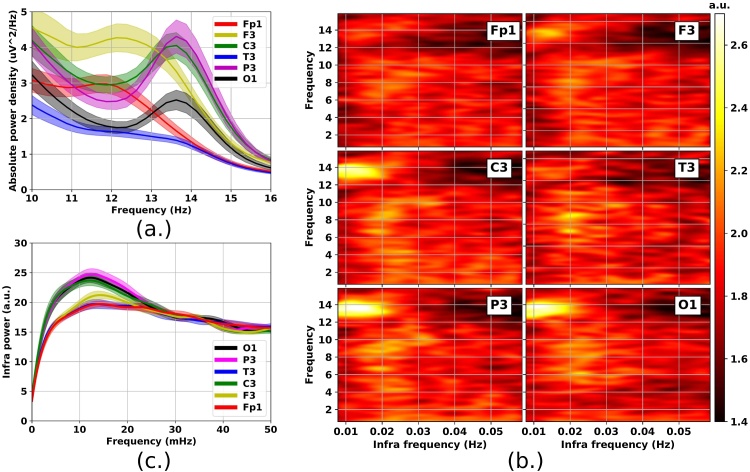
Effect of topography on ISO (relative infra power spectral density of the absolute power spectral density of sleep EEG signals). Average of 34 participants’ baseline NREM stage 2 sleep (contralateral reference). (a) Power spectral density of the sigma band (shaded area = standard error of the mean, SEM). (b) Power spectral density of infra oscillations (arbitrary units). (c) Power spectral density of infra oscillations integrated over the fast spindle sigma band (13–15 Hz) (shaded area = SEM).